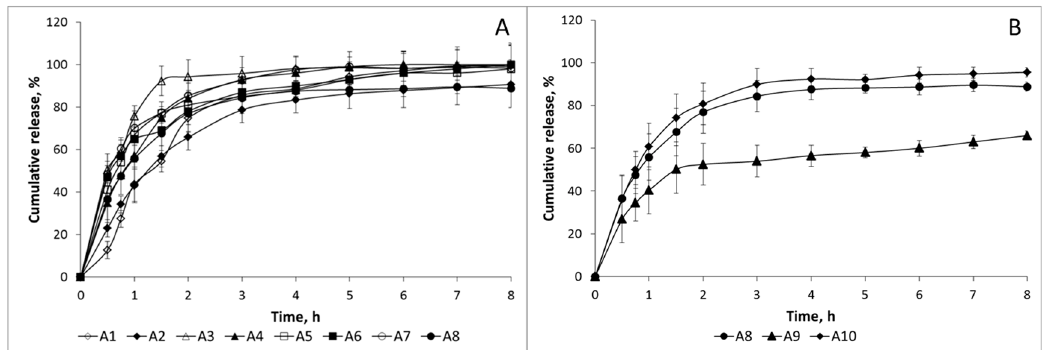
Figure 5. Release pattern in simulated intestinal fluid (SIF) at 37 °C. ( A ) Comparison of formulations with CS:TPP ratio 100:30; ( B ) Comparison of formulations with different CS:TPP ratios. Open symbols, chitosan CS-1; close symbols, chitosan CS-2.